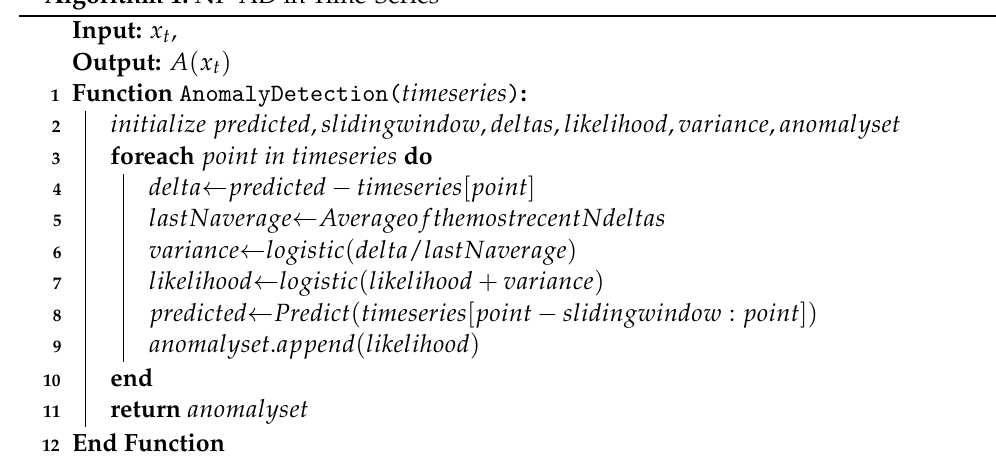
Algorithm 1: NP-AD in